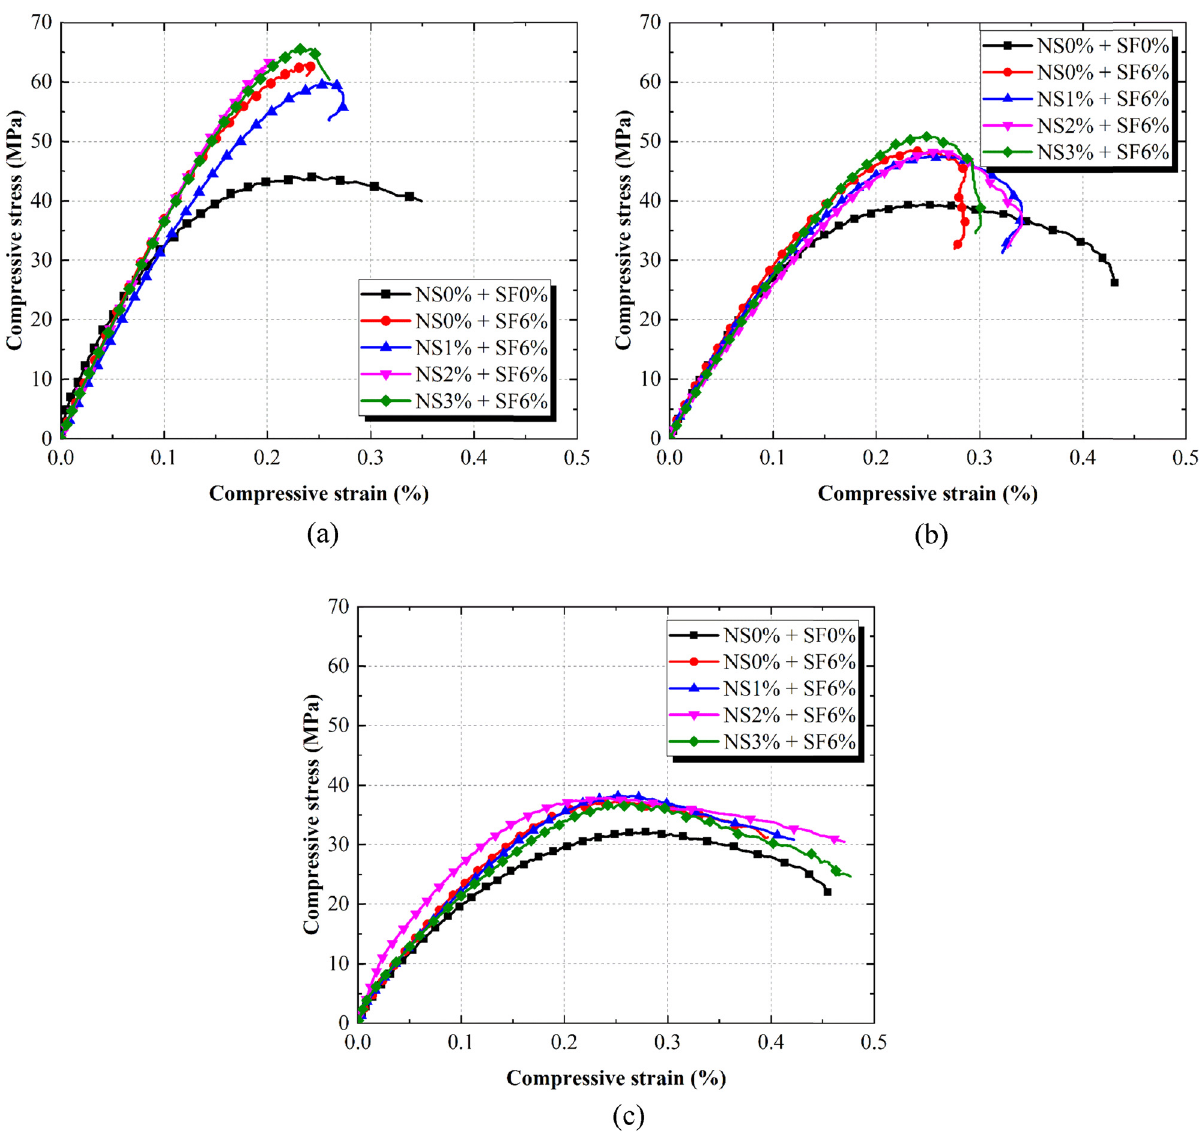
Figure 15: Stress – strain curves for specimens with di ff erent RA replacement percentages. ( a ) 0% RA, ( b ) 50% RA, and ( c ) 100% RA.